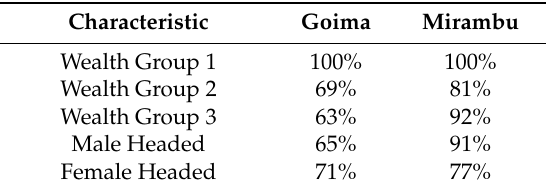
Table 1. Success rates in recontacting original